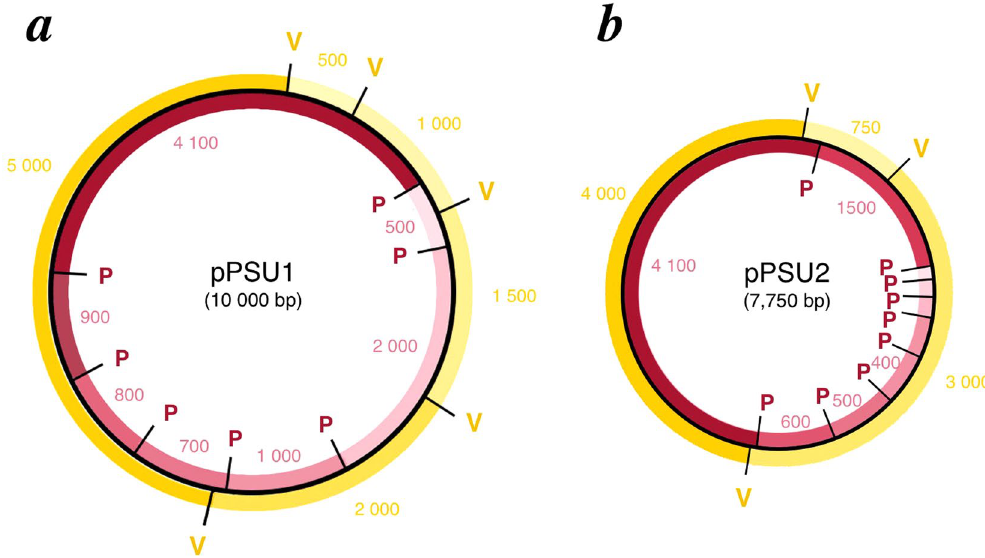
Figure 2. pPSU1 and pPSU2 plasmid maps. Using the nesting approach, nearly 64 kb of 100 bp and 1 kb ladder fragments are incorporated in two high-copy plasmids, pPSU1 (10 kb) and pPSU2 (7.75 kb). The 100 bp ladder fragments produced by PstI digestion of each plasmid are shown in red, and the 1 kb ladder fragments produced by EcoRV digestion are in gold. Restriction sites are denoted by P (PstI) and V (EcoRV). pPSU1 contains the 500, 700, 800, 900, 1000, 2000, and 4100 bp PstI fragments, and 500, 1000, 1500, 2000, 5000 bp EcoRV fragments. pPSU2 contains 50–600, 1500, and 4100 bp PstI fragments, and 750, 3000, and 4000 bp EcoRV fragments. Figure not drawn to